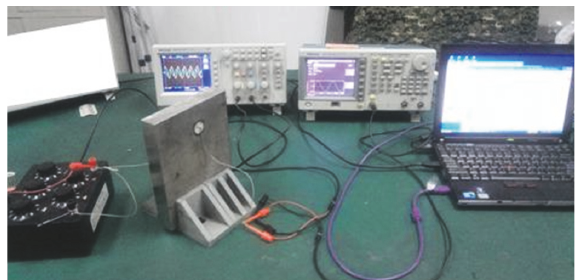
Figure 10: The physical acoustic-electric channel through a planar metal wall and experimental measurement setup.